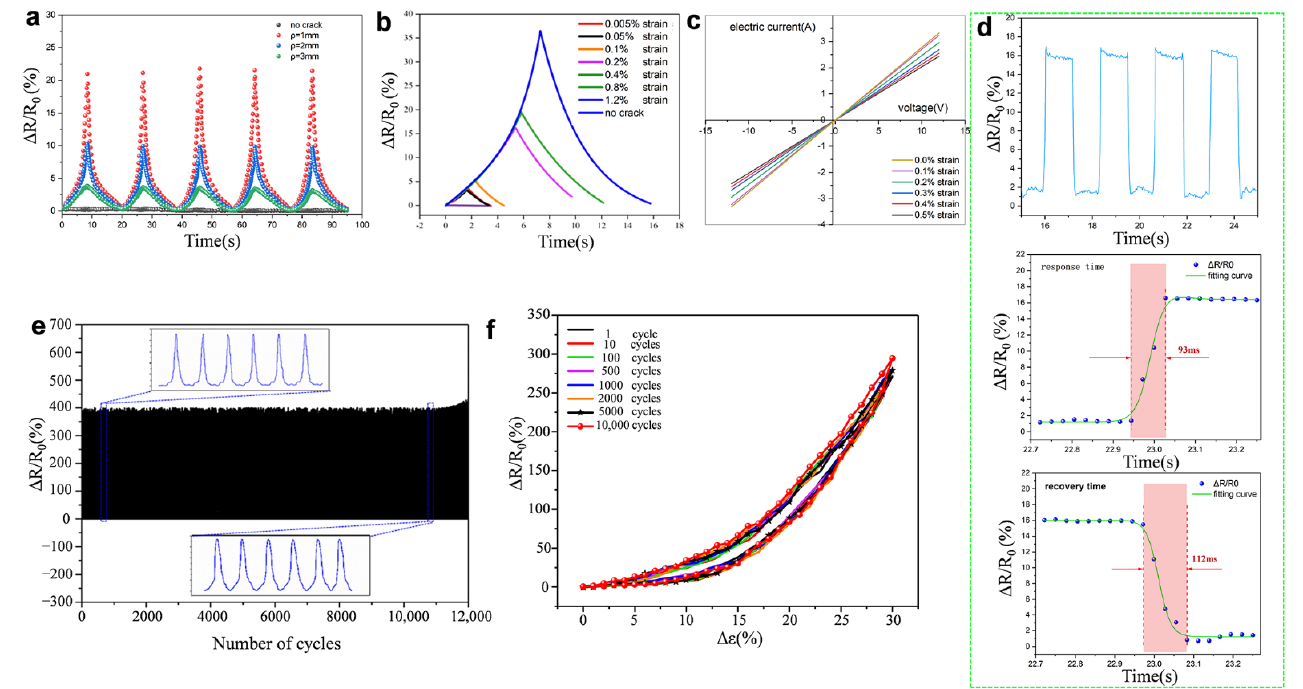
Figure 3. Characterization of the performance of slit-based mechano-sensor. ( a ) The resistance response of various crack-based strain sensor fabricated using different radii of slender rod. ( b ) Reversible loading-unloading behavior for various final strains. ( c ) The current-voltage (I–V) curves of crack-based strain sensor. ( d ) The response and recovery time of the crack-based strain sensor. ( e ) Relative resistance change–time curves of strain sensor for 12,000 loading/unloading cycles. ( f ) The loading–unloading curves at different stages.